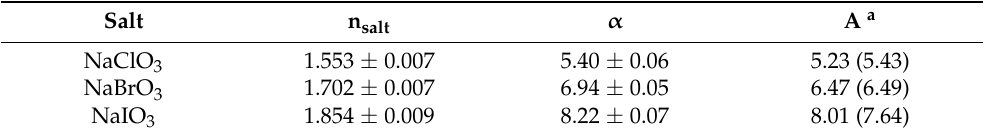
Table 4. Refractive indices ( n salt ) obtained from Equation (A12), and polarizabilities ( α , in Å 3 ) obtained from Equation (A13) compared with the literature values.